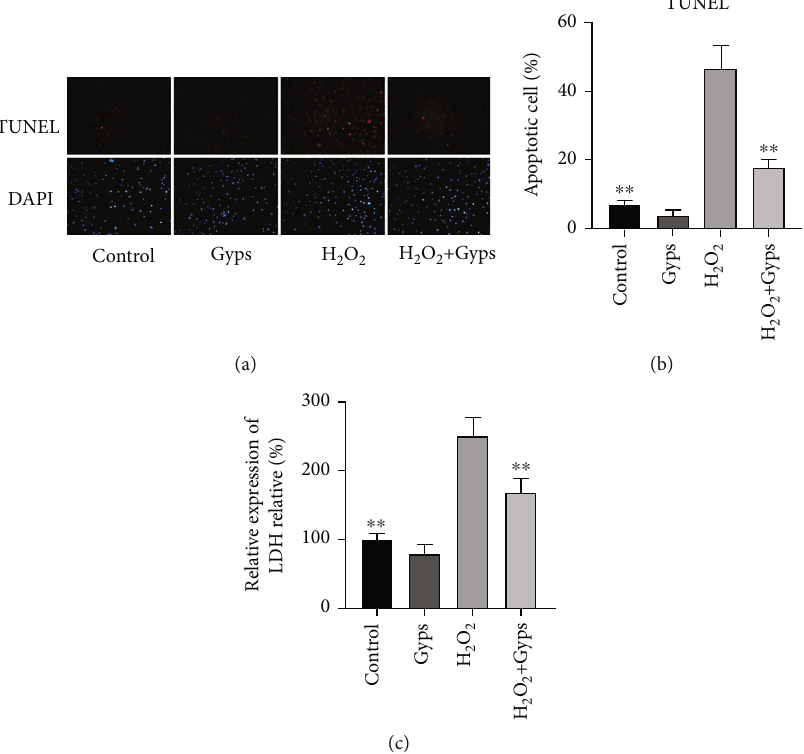
Figure 10: E ff ect of Gyps on late apoptosis induced by H O . (a) Fluorescence photograph. (b) Results of apoptosis rate of each group. (c) 2 2 The absorbance of each group was quantitatively measured by full-wavelength enzyme labeling instrument using LDH detection kit. The results showed that the apoptosis of H O +Gyps was signi fi cantly decreased. Three samples from each of the three GO donors were 2 2 taken for the experiment. All detections are repeated 3 times, with 3 replicate wells each time ( ∗ as P < 0 : 05 and ∗∗ as P < 0 : 01 ; P < 0 : 05 means the di ff erence is statistically signi fi cant, and P value is analyzed by one-way